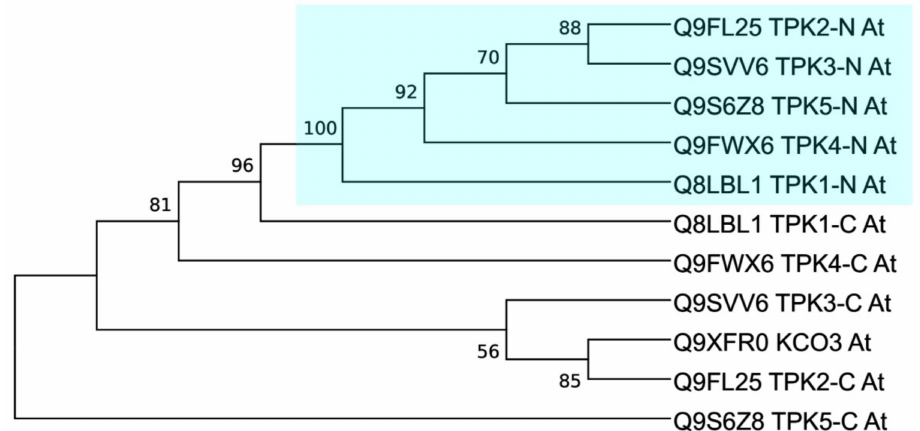
Figure 3. Phylogeny estimation of the Arabidopsis thaliana N- and C-terminal pore modules. The maximum likelihood method and LG substitution model were used. N-terminal pores are